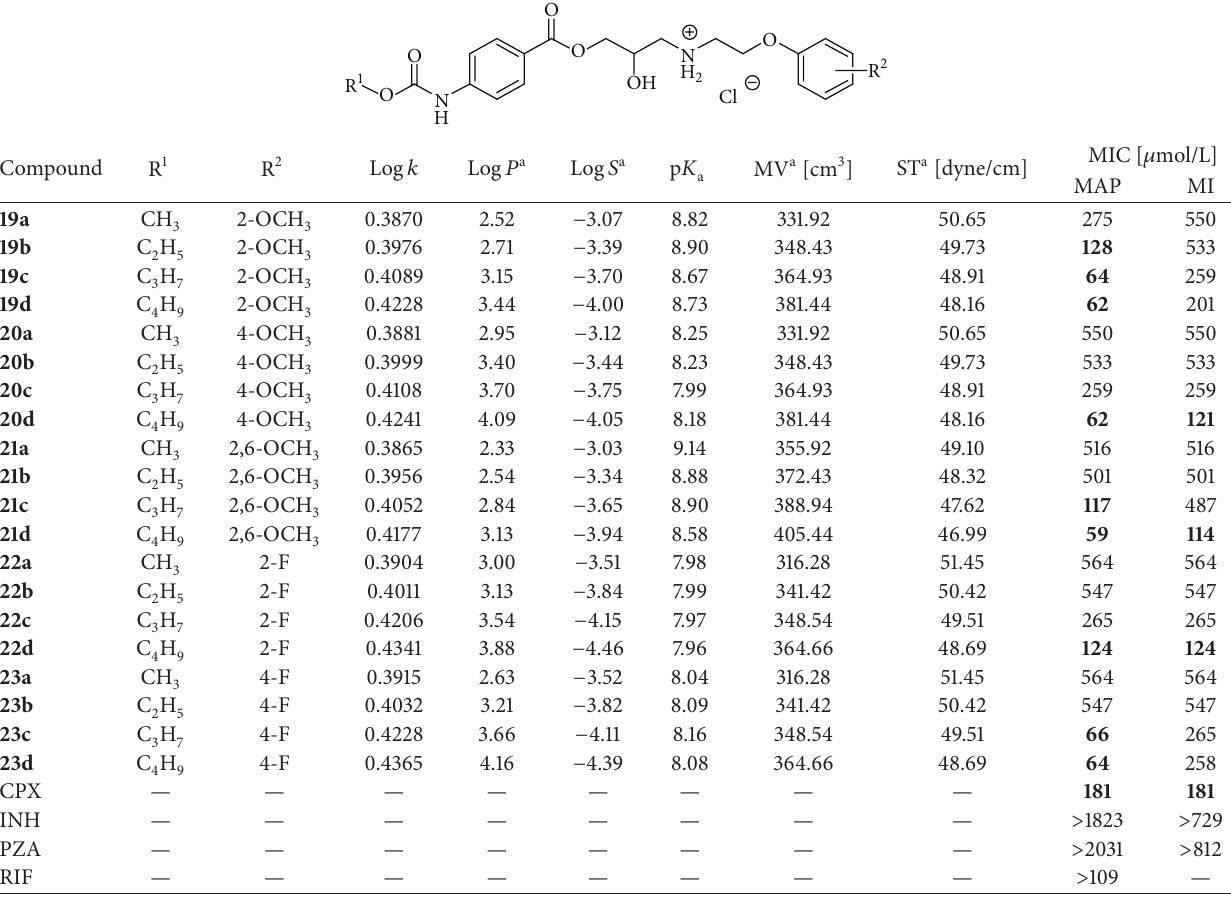
Table 1: Structure of the target compounds 19a – 23d and comparison of calculated lipophilicities (log 𝑃 ) with determined log 𝑘 values; calculated values of solubility (log 𝑆 ), molar volume (MV [cm 3 ]), surface tension (ST [dyne/cm]), and determined p K antimycobacterial activity (MIC [ 𝜇 mol/L]) of compounds compared to ciprofloxacin (CPX), isoniazid (INH), pyrazinamide (PZA), and rifampicin (RIF)